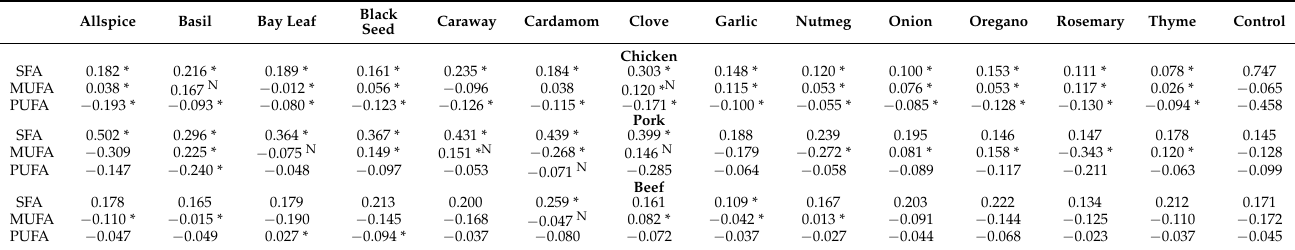
Table 4. The values of regression coefficients ( β ) determined by the multiple linear regression analysis (MLR) for saturated fatty acid (SFA), monounsaturated fatty acid (MUFA), and polyunsaturated fatty acid (PUFA) changes of raw chicken, pork, and beef samples during refrigerated storage at 4 ◦